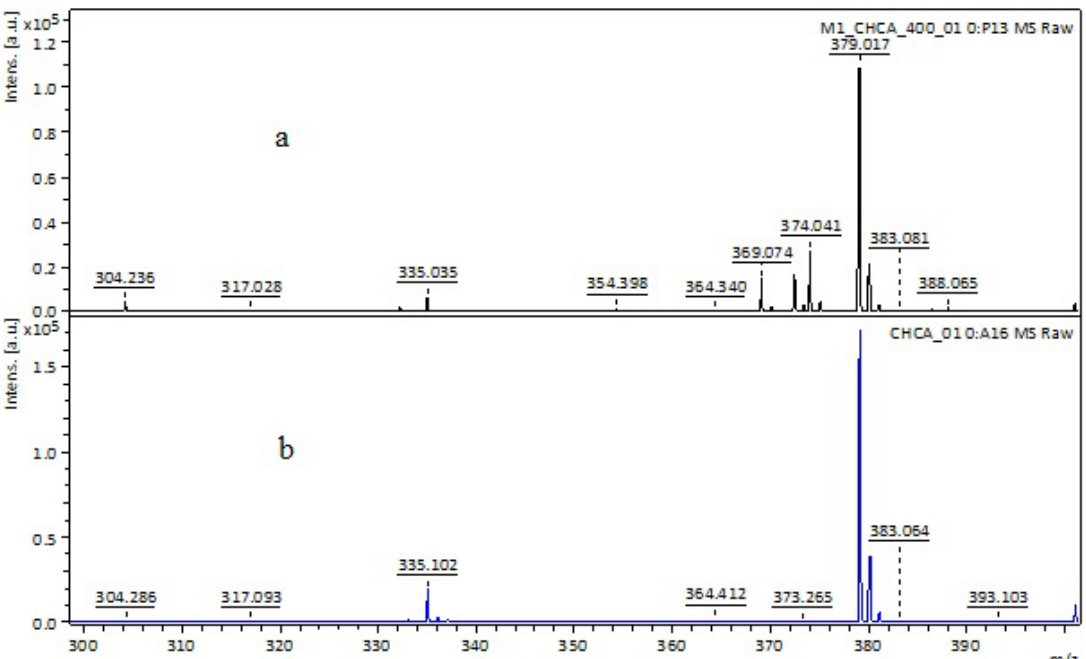
Figure 2. MALDI spectra: a. Spectrum of 1-methyl-3-methoxysilyl propyl imidazolium with the matrix CHCA b. Spectrum MALDI of the matrix CHCA. Approach between 300-400 m/z.